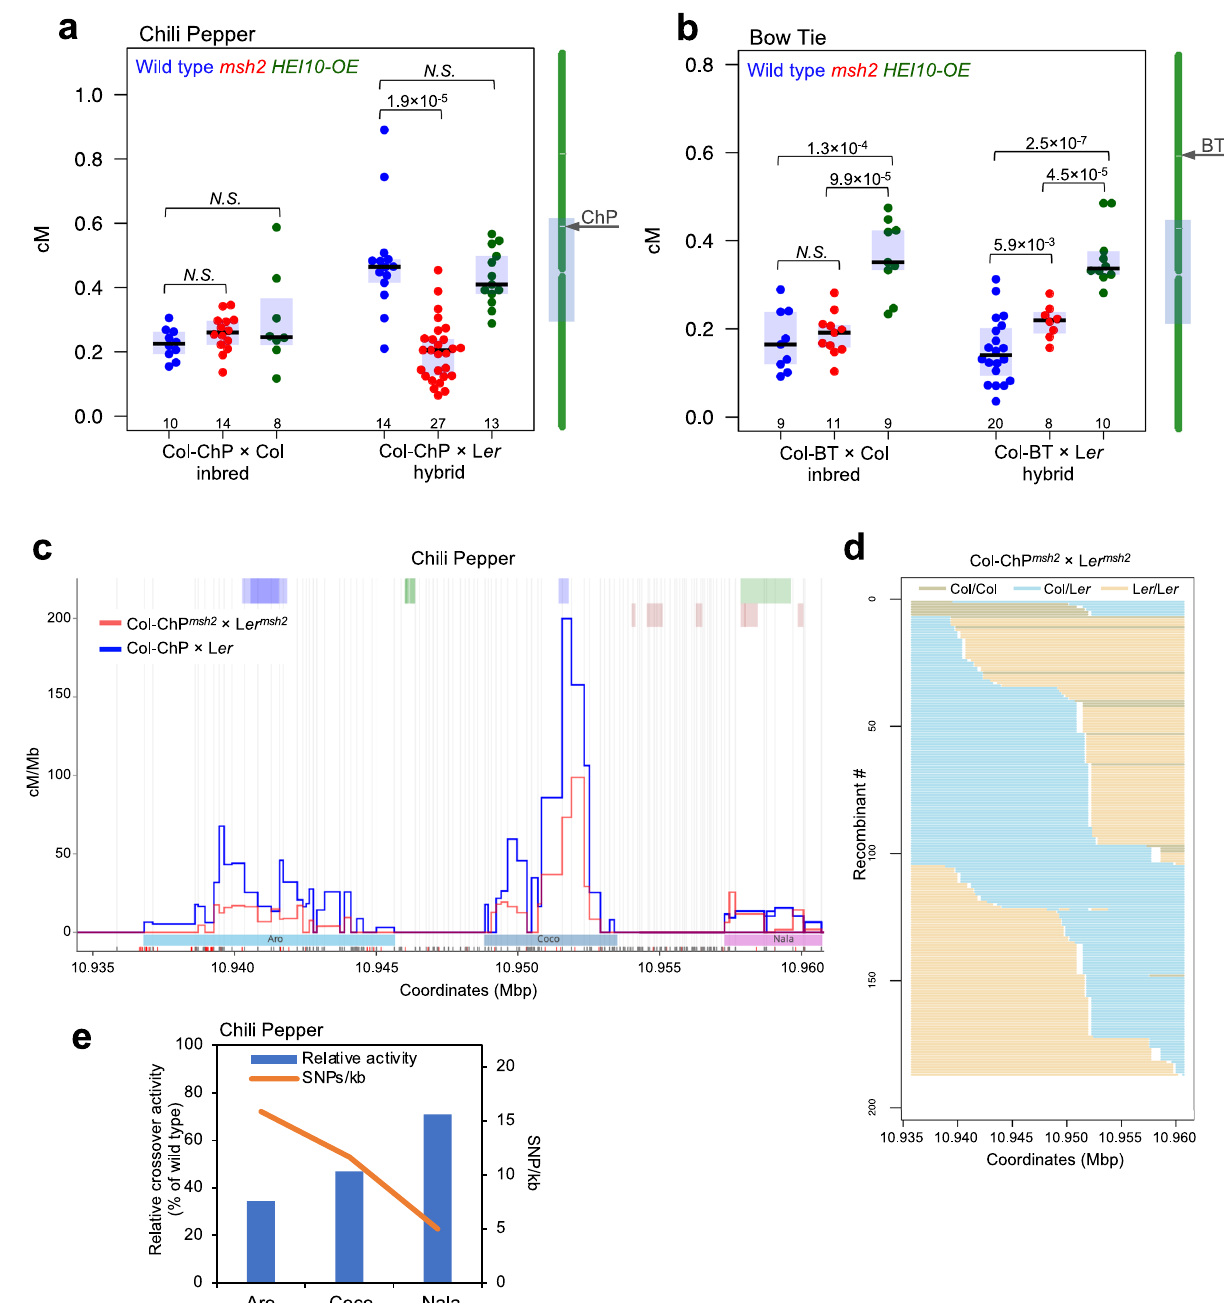
Fig. 5 | Effect of SNP, the msh2 mutation, and HEI10 overexpression on CO frequency. a CO frequencyforCol-ChP × Colinbredsand Col-ChP × L er hybridsin the wild-type, msh2 , and HEI10 overexpression ( HEI10-OE ) genetic contexts. The center line of a boxplot indicates the mean; the upper and lower bounds indicate the 75th and 25th percentiles, respectively. Each dot represents a measurement from one individual. The numbers of individuals are also indicated below the boxplots. The two-sided P values were estimated by Welch ’ s t -test. The chromo- some 3 ideogram with the location of the ChP interval in relation to the pericen- tromere(graybox)isshowntothe right. b Asin a , butfortheBTinterval(Col-BT× ColinbredsandCol-BT×L er hybrids). c ComparisonoftheCOlandscapewithinthe ChP interval for the Col-ChP × L er wild type (blue) and Col-ChP msh2 × L er msh2 (red).